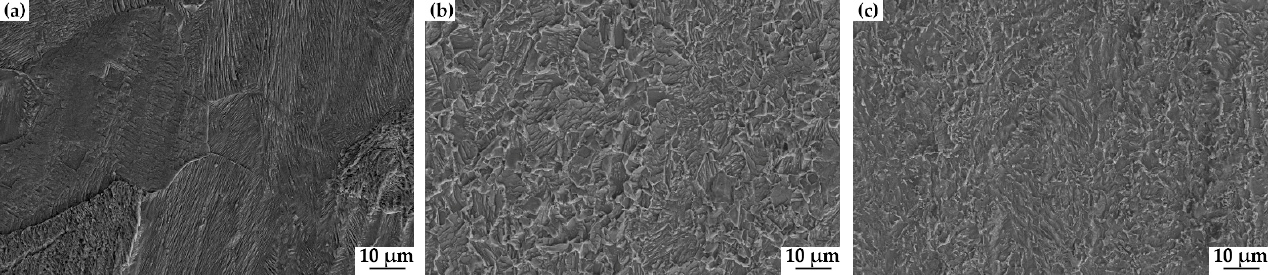
Figure 7. The morphology of 20# ( a ), X60 ( b ), and X80 ( c ) after removal of corrosion products after 14 days immersion.